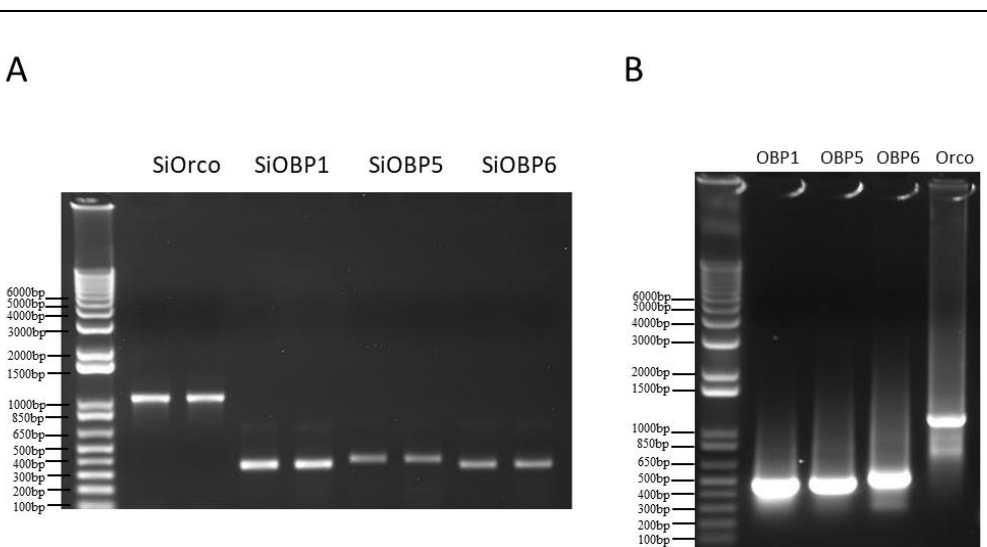
Figure 1. ( A ) The electrophoresis gel of each PCR product (SiOrco, SiOBP1, SiOBP5, and SiOBP6), which was used as a template for the dsRNA synthesis. ( B ) The electrophoresis gel of each dsRNA of SiOBP1, SiOBP5, SiOBP6, and SiOrco, which was used for feeding and injection.